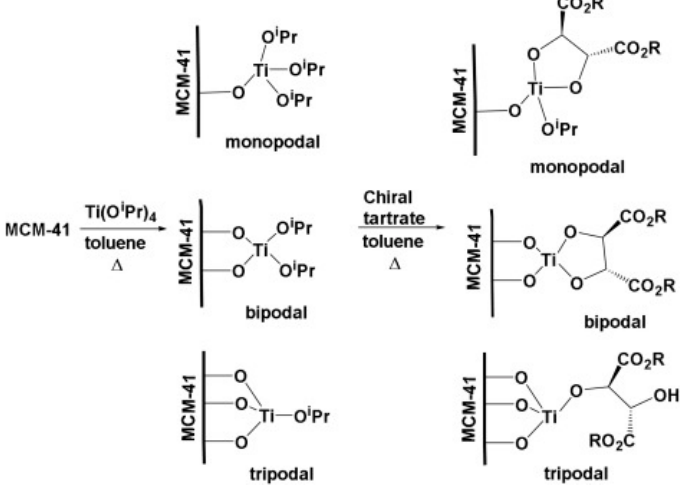
Figure 32 . Possible surface Ti species. Reproduced with permission from [44]. Copyright 2016 Elsevier B.V.